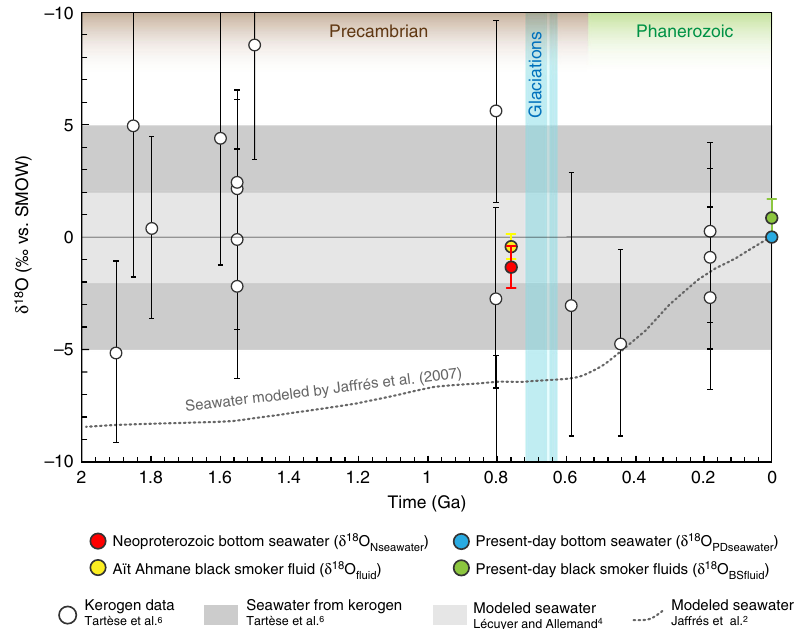
Fig. 7 Oxygen isotopic compositions of the Aït Ahmane hydrothermal fl uid and estimate of Neoproterozoic bottom seawater δ 18 O compared with existing estimates along the past 2 Ga. Error bars for δ 18 O values of Aït Ahmane black smoker fl uid and Neoproterozoic seawater were calculated following error propagation considering errors on mean δ 18 O value measured on magnetite, on temperature-dependent water – magnetite fractionation and on Δ 18 O BS fl uid- σ of the compiled data, Fig. 6), see Supplementary Table PDseawater (2